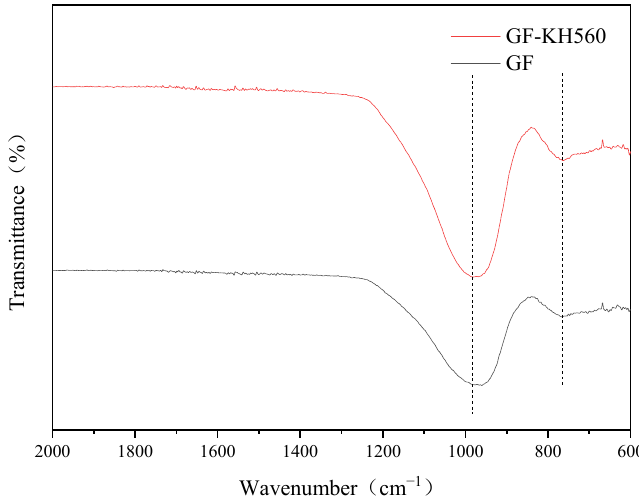
Figure 7. Infrared spectrum of glass fibre before and after modification.